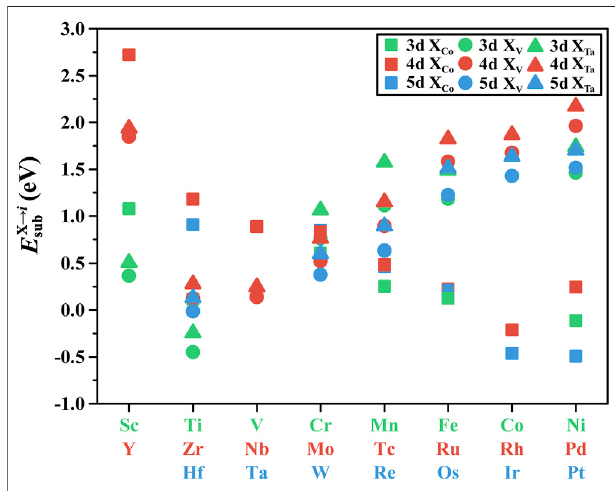
FIGURE 2 | Reaction energy for the TM-substituted γ ′ -Co 3 (V, Ta). The square, round, and triangle markers denote TM elements occupying the Co, V, and Ta sites, respectively.